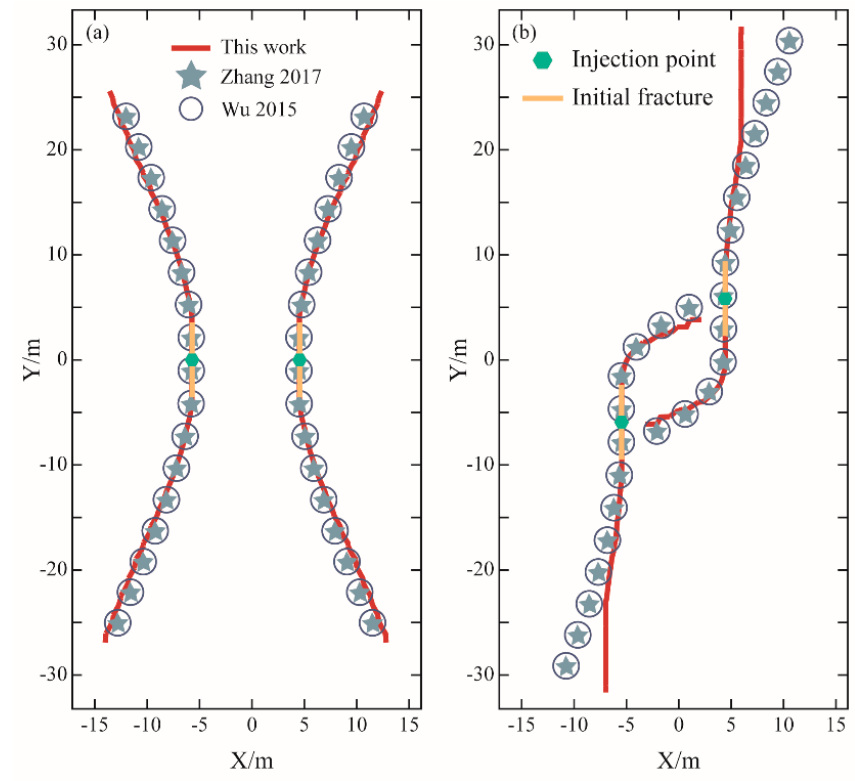
Figure 1. Compared with the fracture paths of Zhang et al. [24] and Wu et al. [25]. ( a ) Two parallel fractures. ( b ) Two offset fractures.